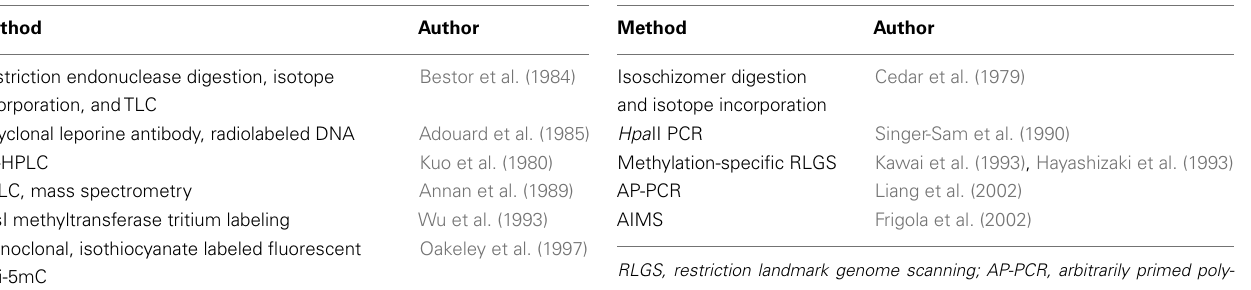
Table 1 | Summary of early non-specific methods. Table 2 | Summary of early differential gene methylation